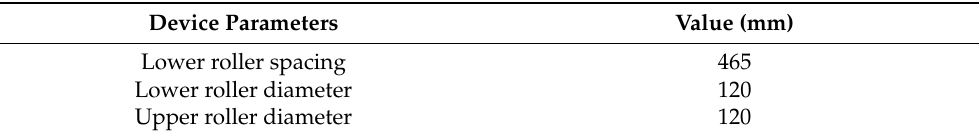
Table 3. Detailed parameters of the experimental